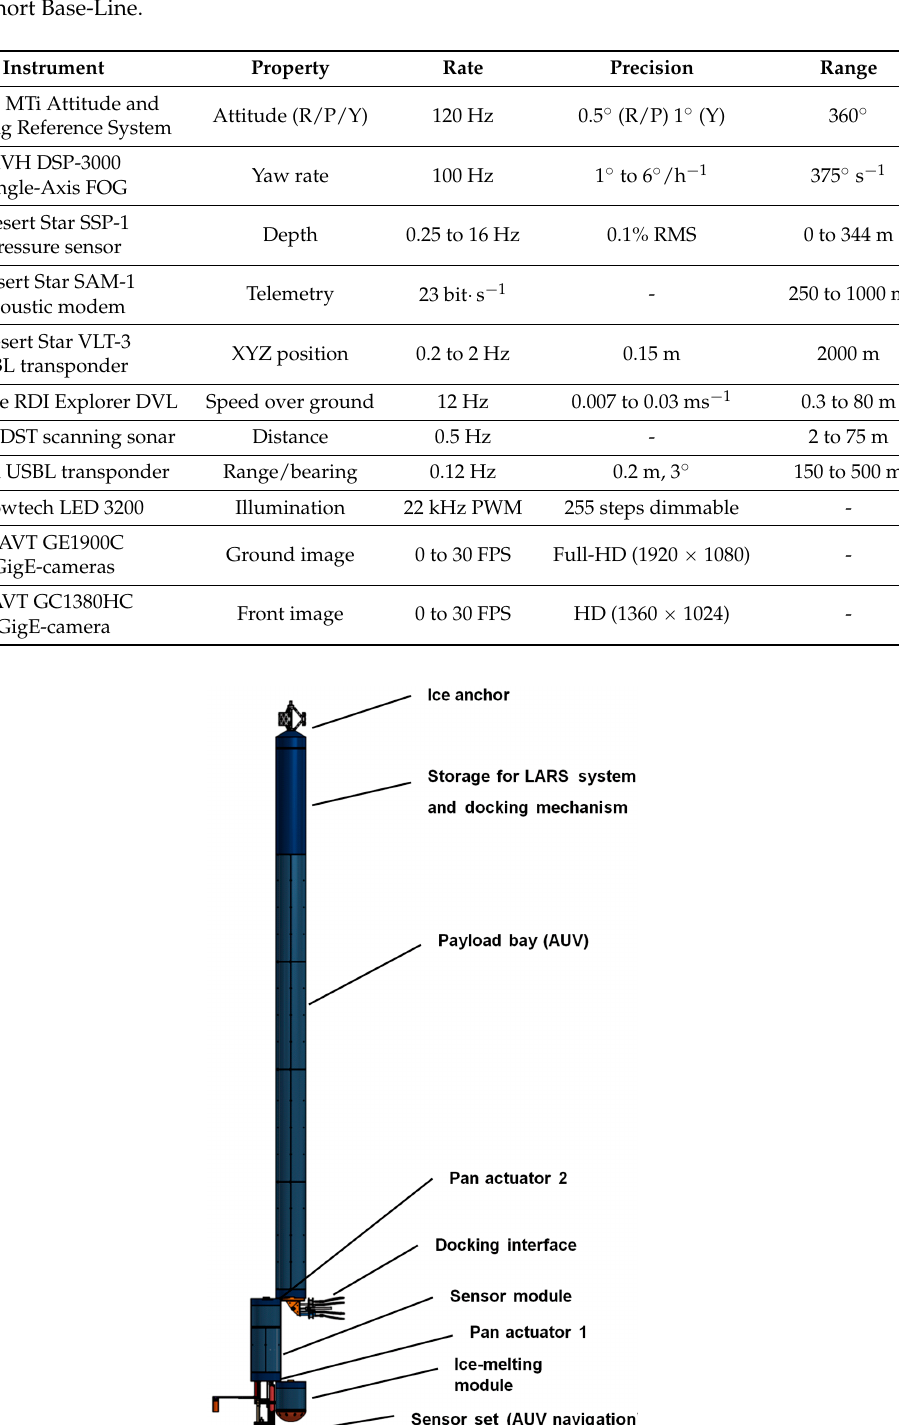
Table 1. Instrumentation of the “Dagon” AUV as an example of a well-instrumented vehicle. FOG, Fiber-Optic Gyroscope; LBL, Long-Baseline-Localization; DVL, Doppler Velocity Log; USBL, Ultra-Short Base-Line.